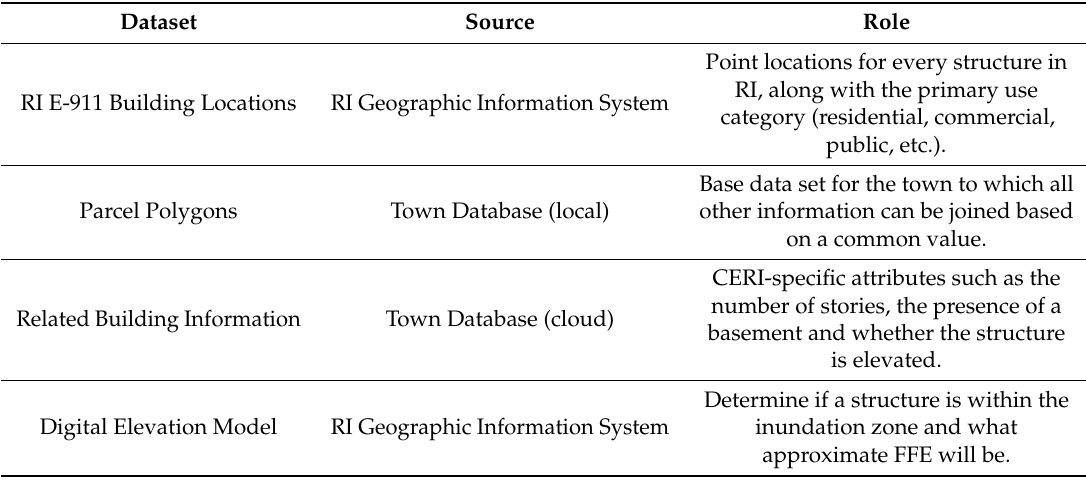
Table 1. CERI input data and source.